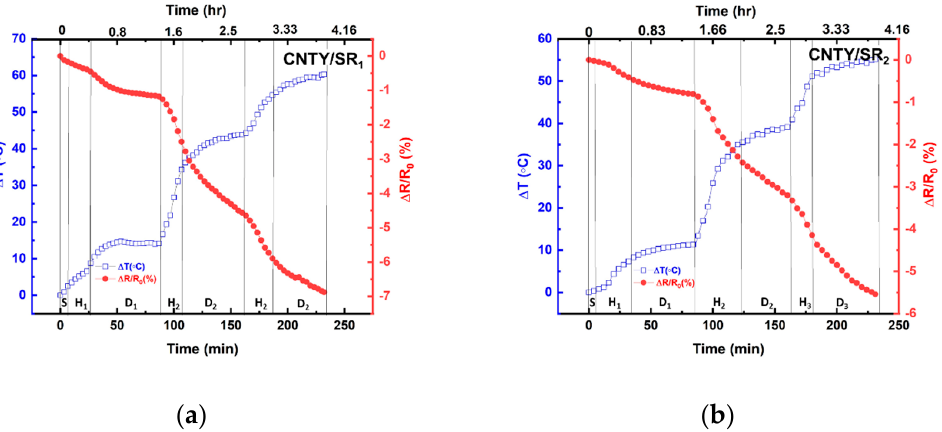
Figure 5. Temperature change and fractional change in electrical resistance during increasing-dwell temperature program of: ( a ) CNTY/SR 1 ; ( b ) CNTY/SR 2 .